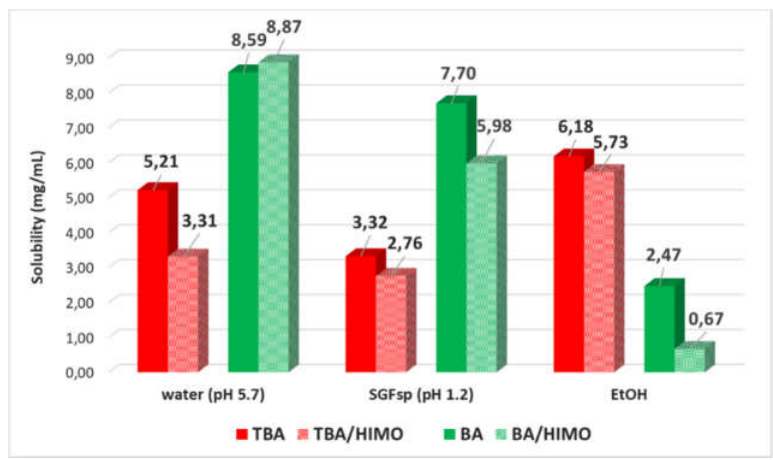
Figure 17. Results of solubility measurements of TBA and BA and their cocrystals with HIMO.